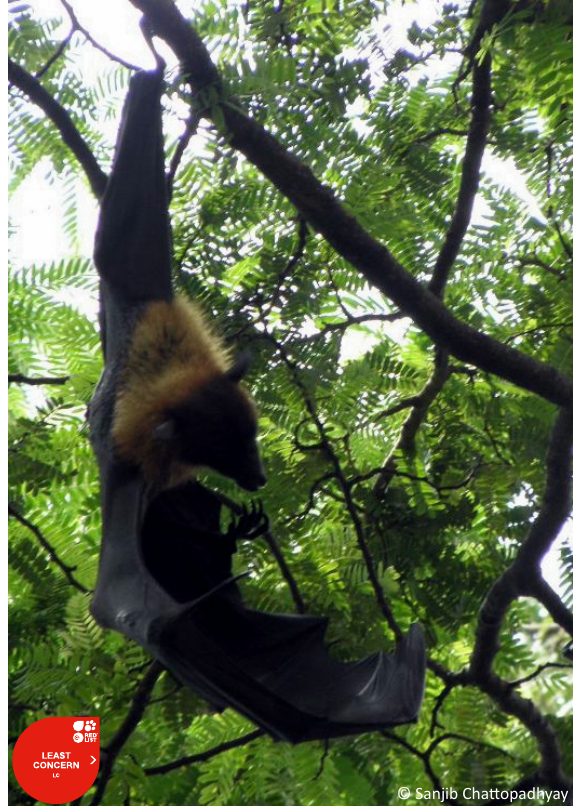
Image 1. Bat showing stretching and fanning behaviour of patagium to avoid excessive ambient temperature.